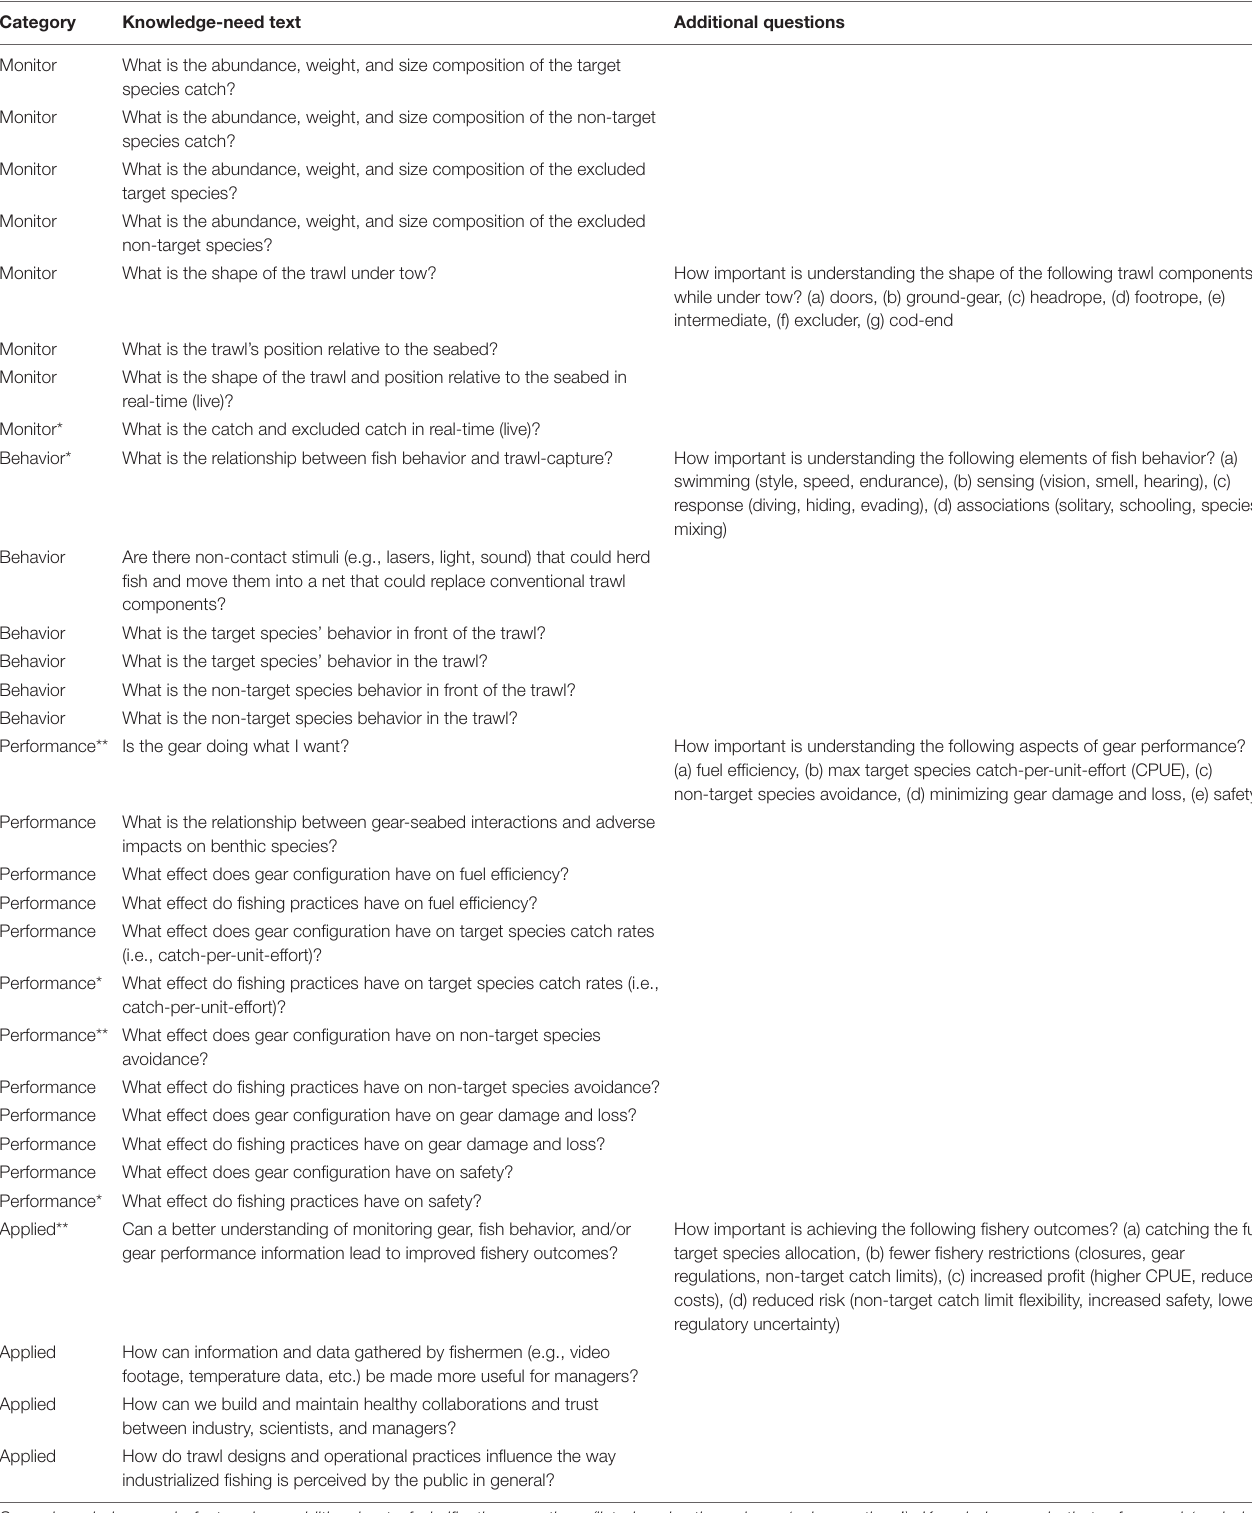
TABLE 1 | List of all knowledge-needs and their associated categories presented in the pre-workshop online survey, and an indication of those selected for the in-person workshop (* knowledge-need was selected for the workshop; ** knowledge-need was selected for the workshop, but an additional series of questions helped refine the